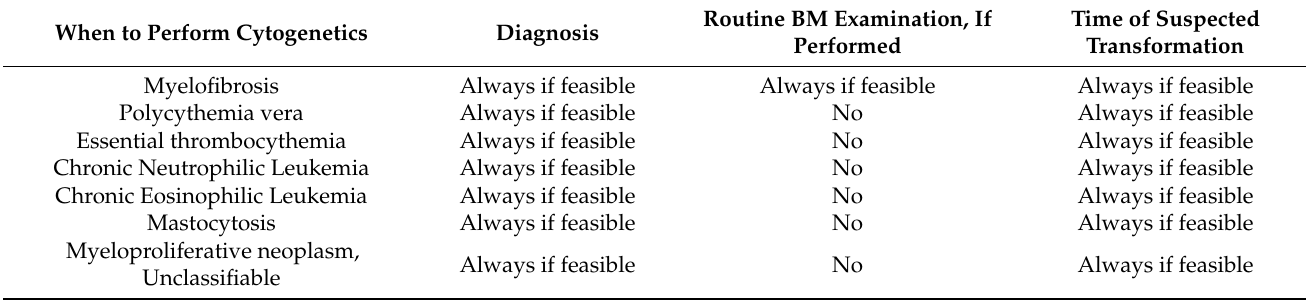
Table 3. Suggested cytogenetics